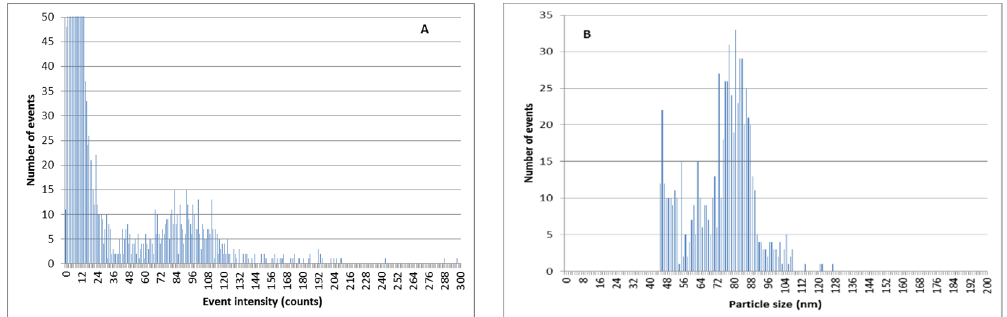
Figure 10. SP-ICPMS histograms of a mixture of Ag + and PVP-AgNPs of 75 nm 5:1 after double extraction procedure with 50 mg resin. ( A ) Signal distribution. ( B ) Particle size distribution.